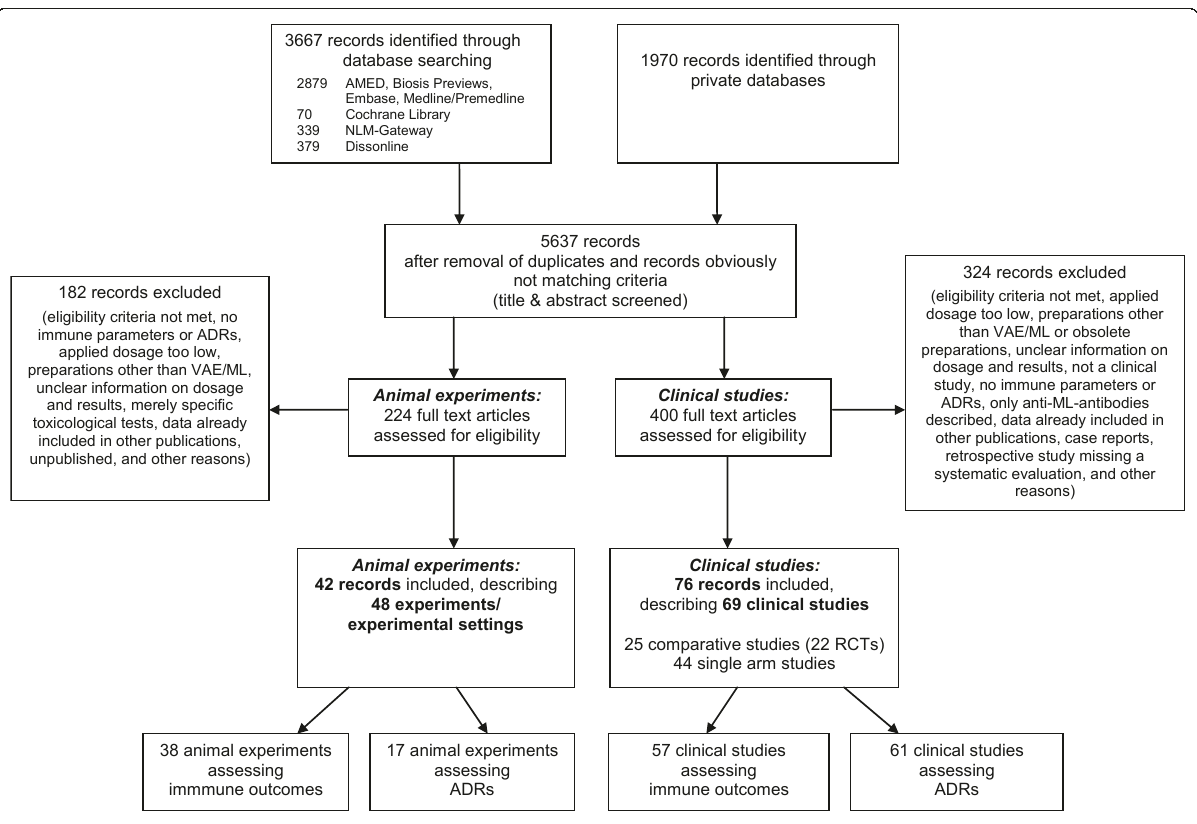
Figure 1 Literature search and study selection